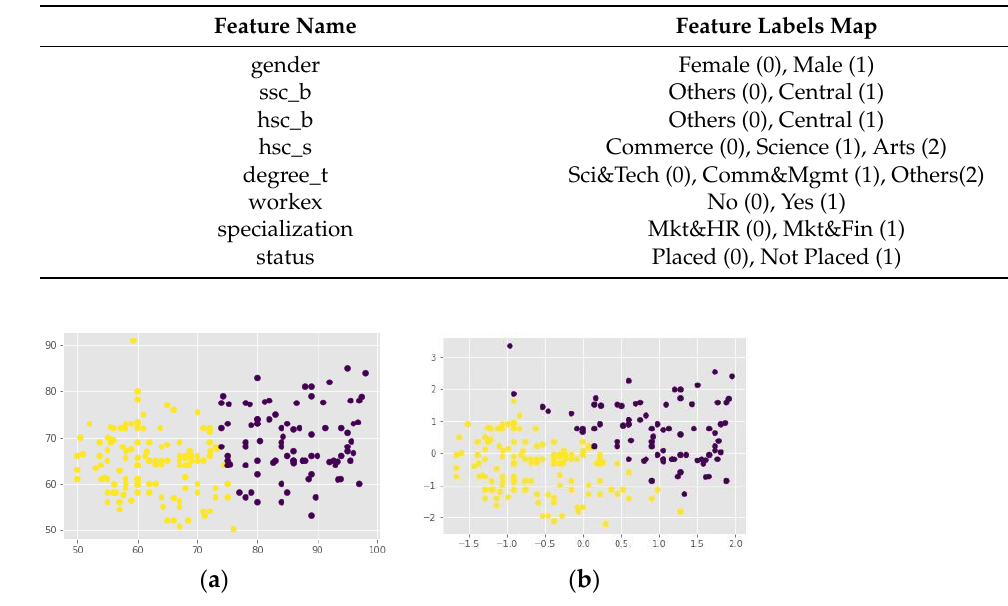
Figure 2. The distribution of the data before and after normalization: ( a ) the distribution before normalization; ( b ) the distribution after normalization.